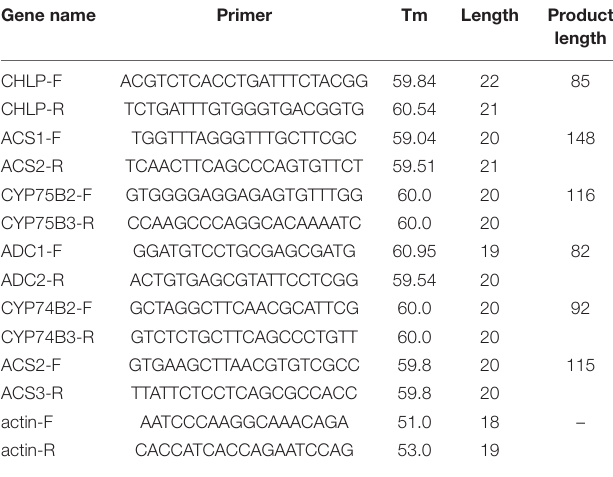
TABLE 2 | The information of qPCR